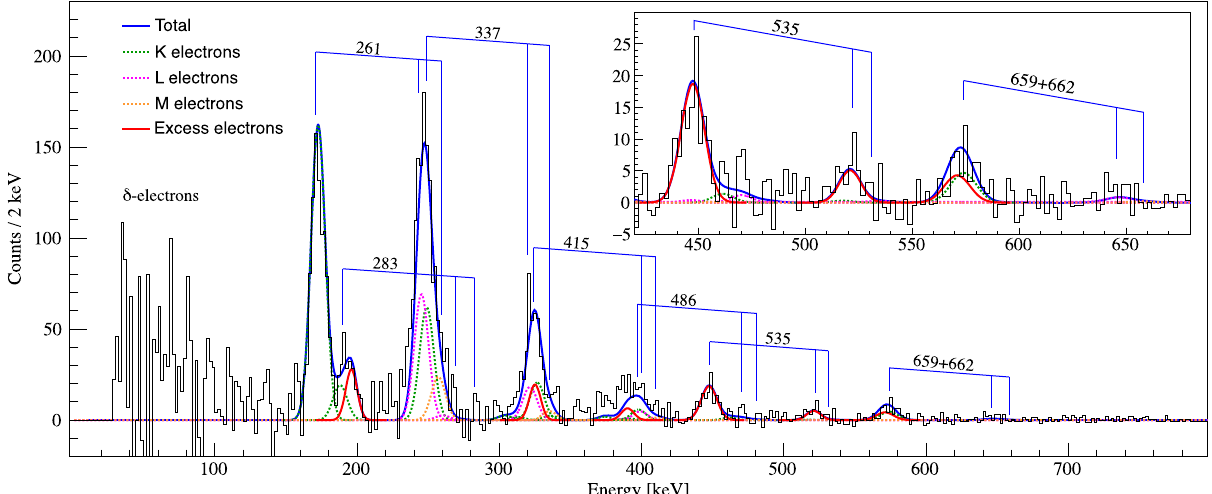
Fig. 2 Recoil-gated, α -tagged background-subtracted electron energy spectrum. The K-, L- and M-components of the most prominent transitions are marked and labelled with transition energies. The total fi t is shown with the blue line. The green, purple and orange dotted lines indicate the calculated K-, L- and M-electron components extracted from the corresponding γ -ray intensities, respectively. The excess electrons are marked with the red line. The δ - electron fl ux dominates below 150 keV. The inset shows a close-up of high-energy transitions.